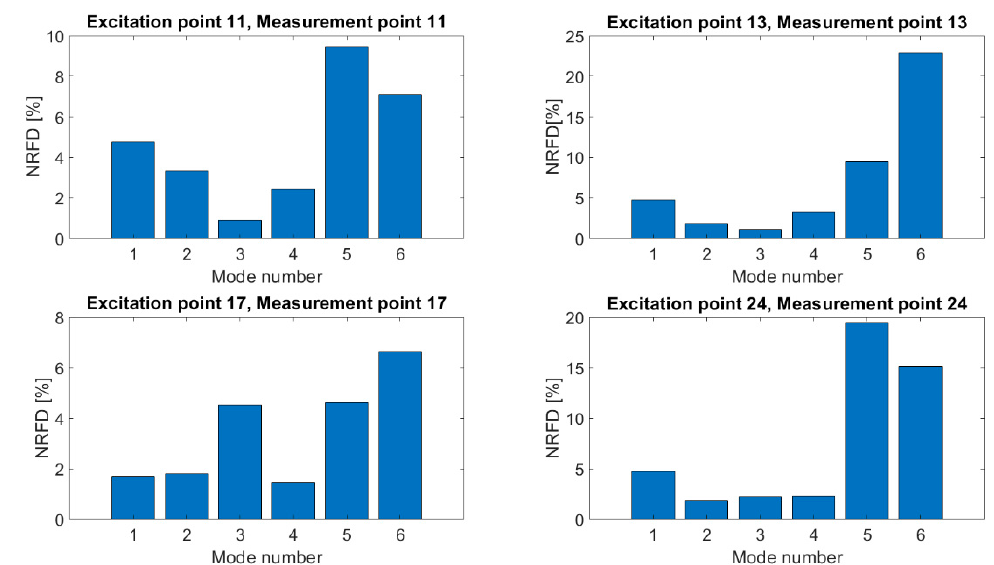
Figure 15. NRFDs of the first six resonances at points 11, 13, 17, and 24.